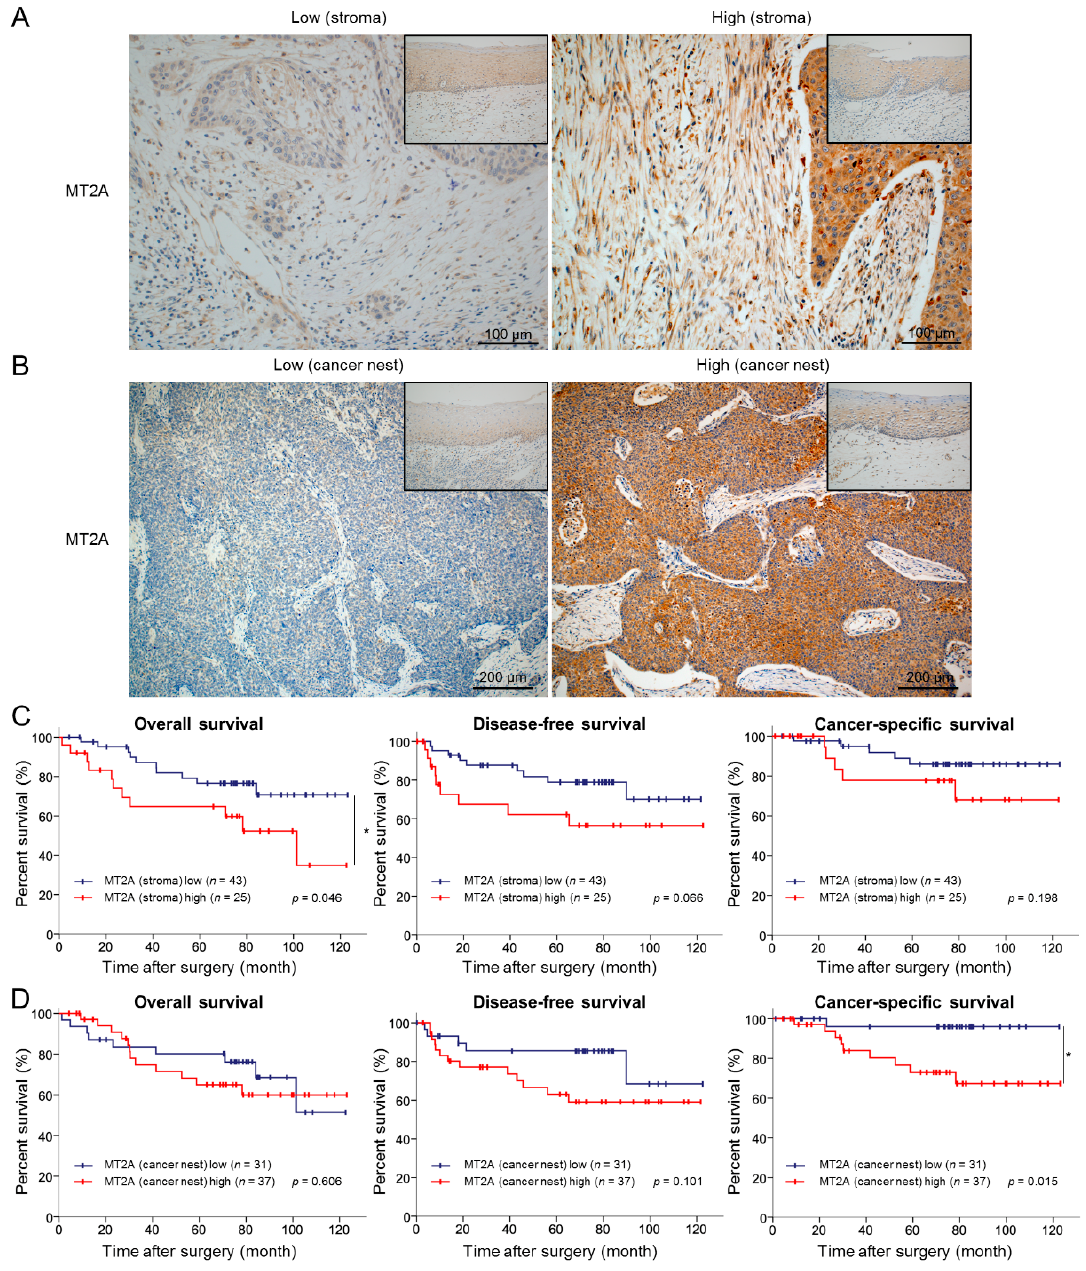
Figure 6. High expression levels of MT2A in the cancer stroma and cancer nest correlated to a poor prognosis of ESCC patients. ( A ) Immunohistochemical staining for MT2A in the cancer stroma of 69 human ESCC tissues. Representative immunostaining images show low intensity (left) and high intensity (right) with corresponding normal esophageal squamous epithelia (insets). Scale bars = 100 µ m. ( B ) Immunohistochemical staining for MT2A in the cancer nest of 69 human ESCC tissues. Representative immunostaining images show low intensity (left) and high intensity (right) with corresponding normal esophageal squamous epithelia (insets). Scale bars = 200 µ m. ( C ) Kaplan–Meier curves for overall survival, disease-free survival, and cancer-specific survival in 68 ESCC patients stratified into two groups based on MT2A expression levels in the cancer stroma: MT2A low cases ( n = 43) and MT2A high cases ( n = 25). ( D ) Kaplan–Meier curves for overall survival, disease-free survival, and cancer-specific survival in 68 ESCC patients stratified into two groups based on MT2A expression levels in the cancer nest: MT2A low cases ( n = 31) and MT2A high cases ( n = 37). Data are analyzed by log-rank test (* p < 0.05).